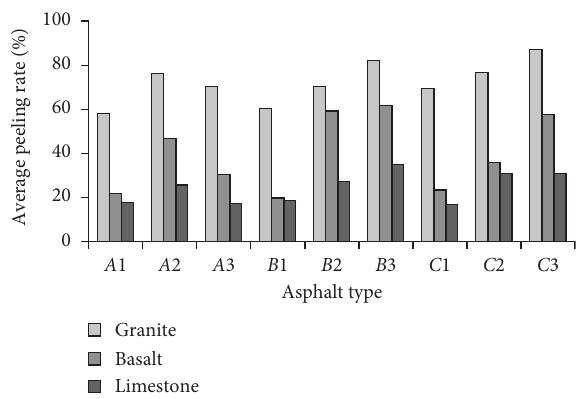
Figure 11: Stripping rate of the asphalt on the aggregate surface and the adhesion